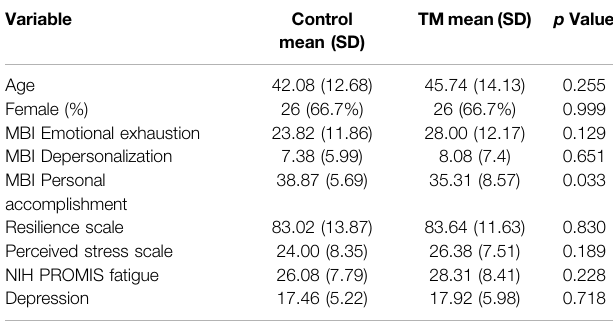
TABLE 1 | Demographic characteristics and baseline Scores by